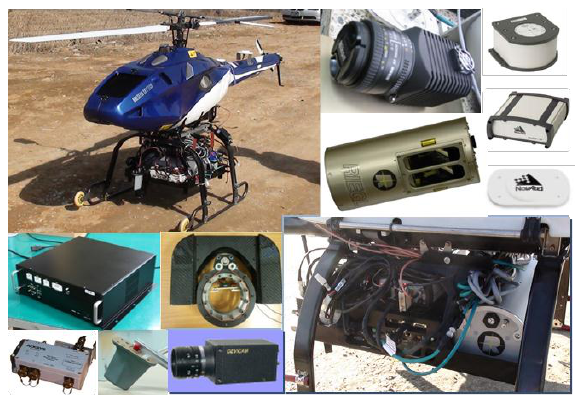
Figure 3. Sensors & Supporting Modules